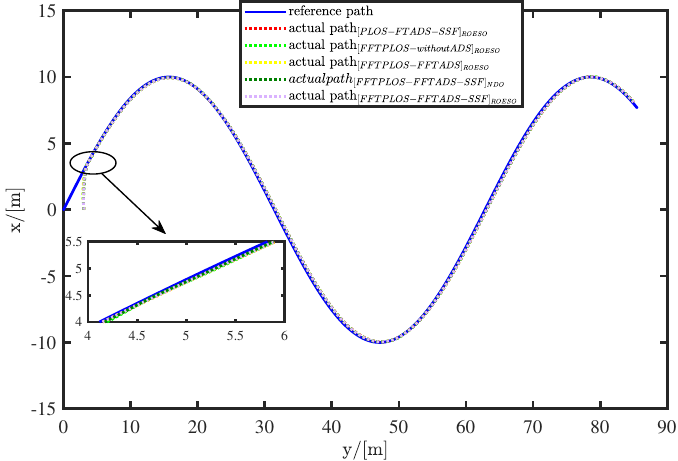
Figure 3. Comparison of path-following trajectory in horizontal